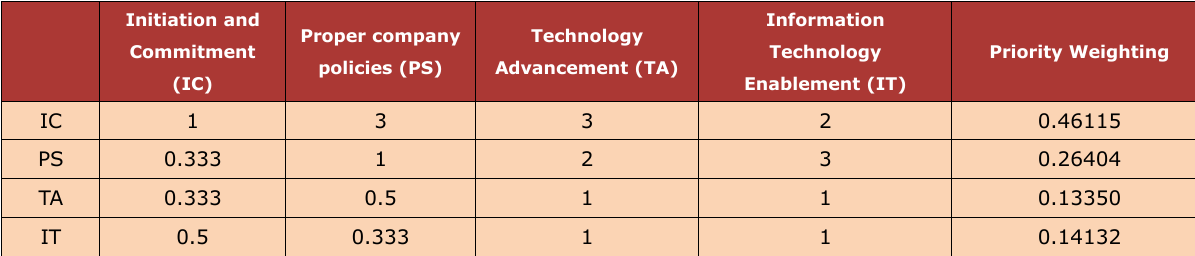
Table 5.2. Strategies of Top management perspective